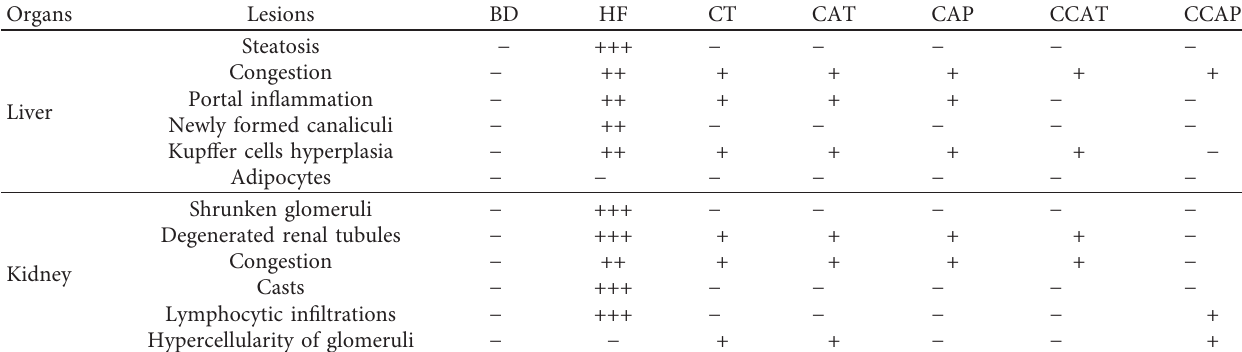
Table 6: Effect of different fermented milk products on histological changes of the liver and kidney in hypercholesterolemic rats. Organs Lesions BD HF CT CAT CAP CCAT CCAP Steatosis Portal inflammation Liver Adipocytes Shrunken glomeruli Kidney